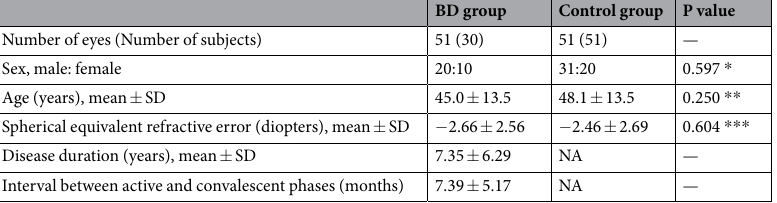
Table 1. Clinical characteristics of ocular Bechet’s disease patients and controls. Dashes indicate that no statistical analysis was conducted for the parameters. * chi-square test, ** unpaired t-test, *** Mann–Whitney U test.